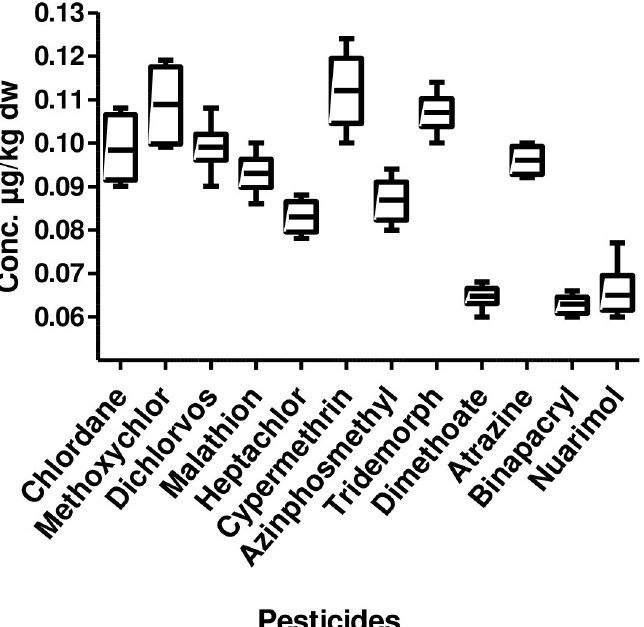
Fig 2. Box and whisker’s plot of pesticide residues in sediment samples from middle stretch of river Ganga.